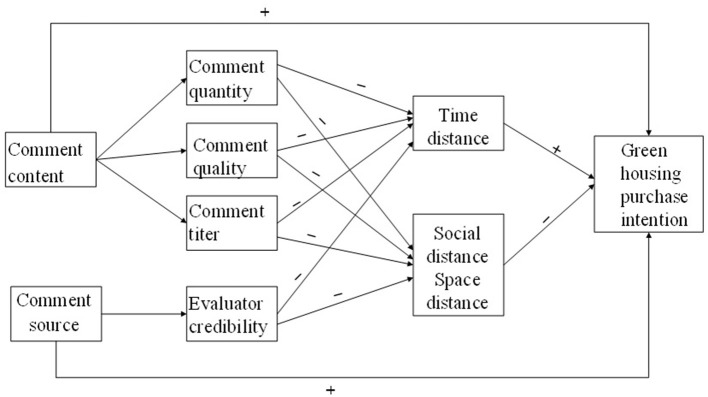
Conceptual model.